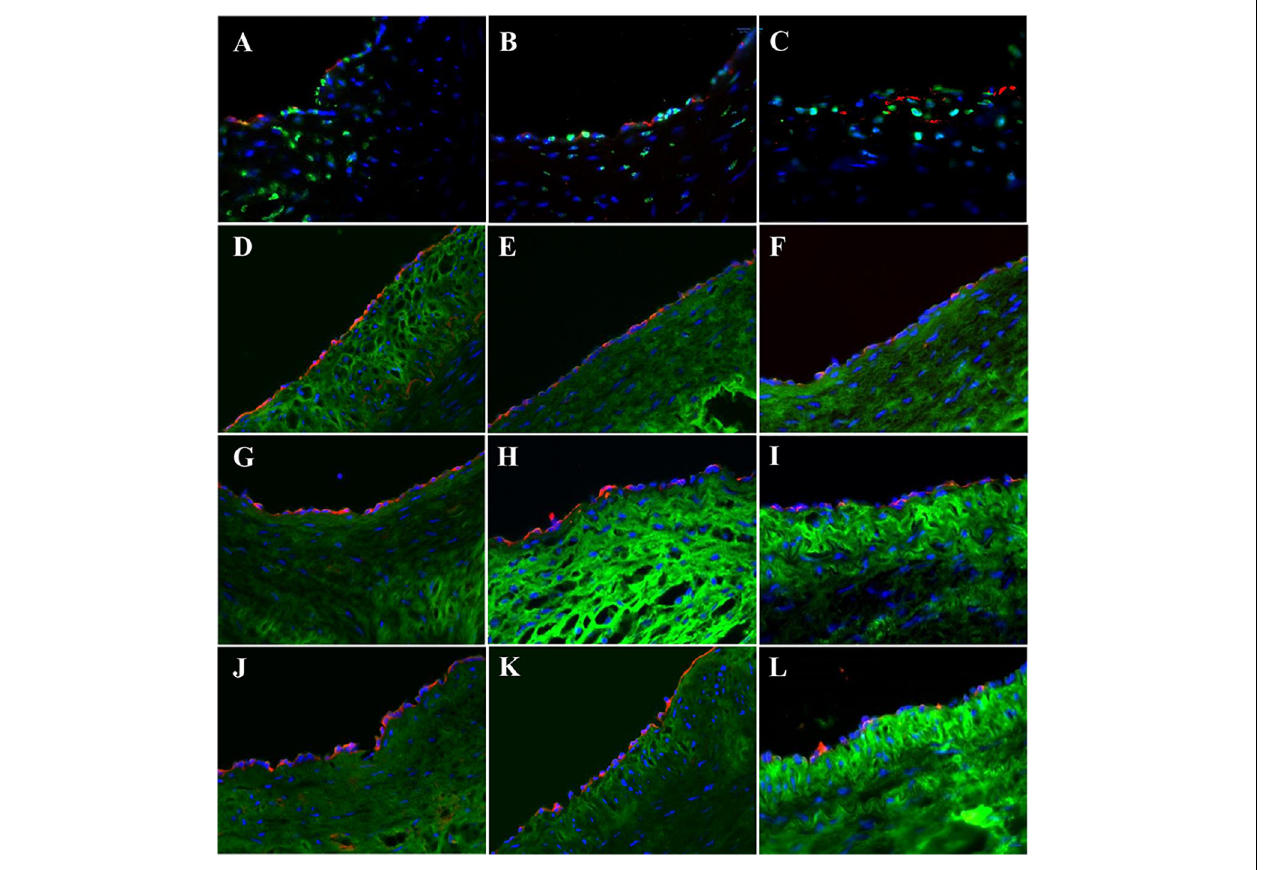
FIGURE 7 | Cholesterol accumulation, transport, and metabolism in carotid patch-angioplasty in HF/4-M Group. (A) Filipin and 7-keto cholesterol in native artery. (B) Filipin and 7-keto cholesterol in bPVP patch. (C) Filipin and 7-keto cholesterol in bPcdm patch. (D) ABCA in native artery. (E) ABCA in bPVP patch. (F) ABCA in bPcdm patch. (G) PSCK in native artery. (H) PSCK in bPVP patch. (I) PSCK in bPcdm patch. (J) ApoE-1 in native artery. (K) ApoE-1 in bPVP patch. (L) ApoE-1 in bPcdm patch. Green in (A–C) Filipin. Red in (A–C) anti-7-keto cholesterol. Green in (D–L) anti-sialic acid (wheat germ agglutinin). Red in (D–F) anti-ABCA. Red in (G–I) anti-PSCA9. Red in (J–L) anti-ApoE-1. Blue in all: nuclei of cells. Objective: 60 ×